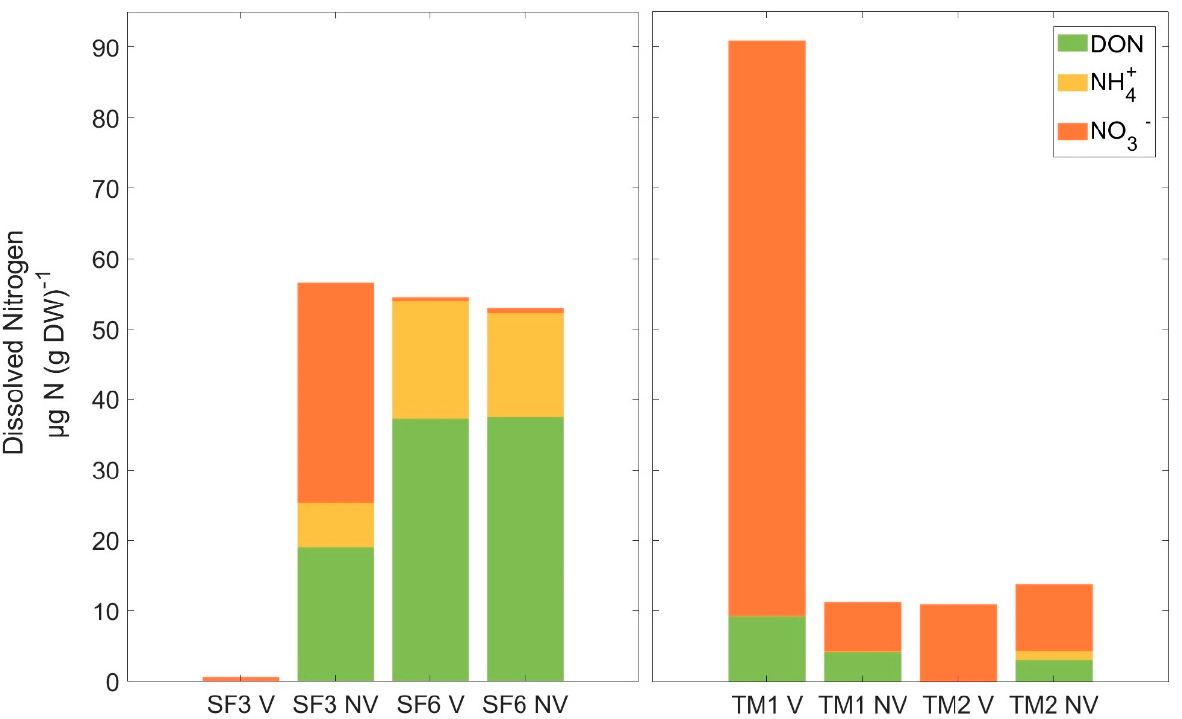
Figure 2. Contribution of dissolved organic nitrogen (DON, green), ammonium (NH 4+ , yellow), and nitrate (NO 3 − , orange) to the total dissolved nitrogen in revegetated (V) and non − vegetated (NV) slump floor (SF, left) and thaw mounds (TM, right) soils. None of the samples contained nitrite. Mean values and standard deviation are shown in Table S3 in the supplements.